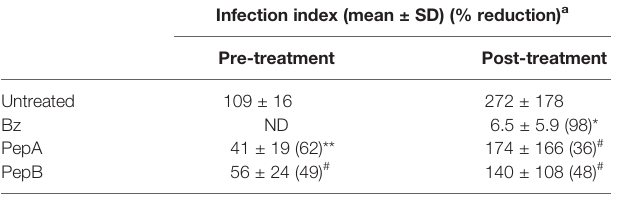
Mean ± SD of the infection index (% of reduction). ND, not determined.